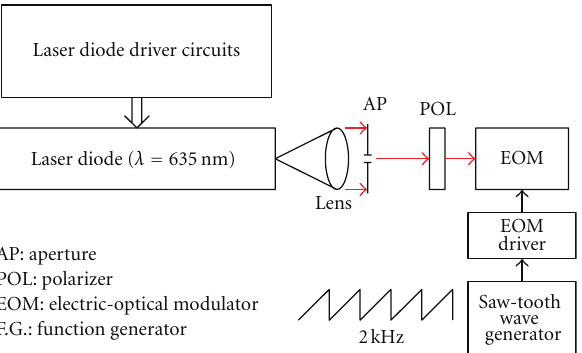
Figure 2: The 3-D structure of the platform driven by a step